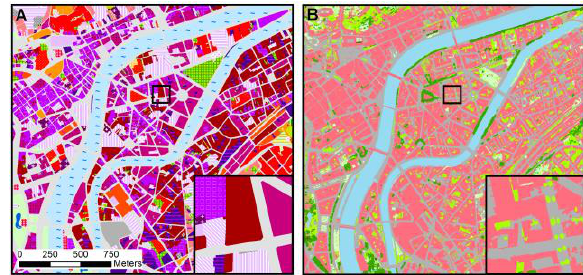
Figure 3. (a) Existing LU map in 71 classes (COSW2007) and (b) new LC map by OBIA in 9 classes (SmartPop)